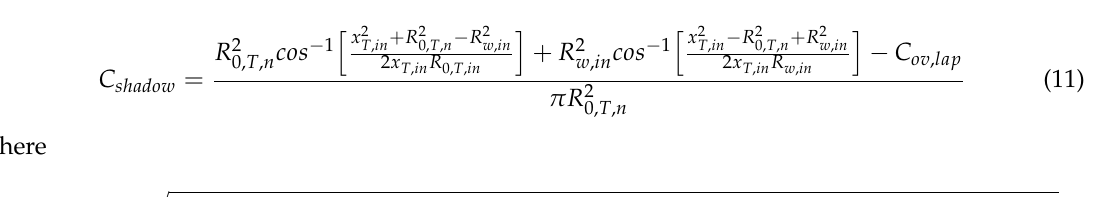
i on T p and T n (top view of the wind